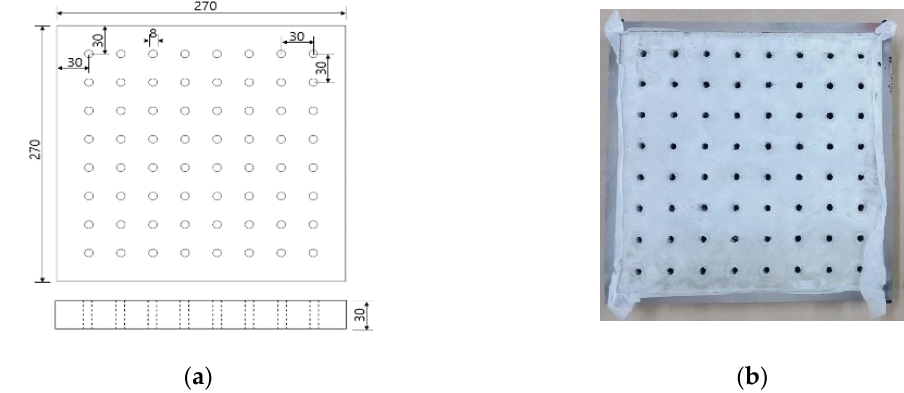
Figure 4. Proposed specimen structure, ( a ) base body dimensions, ( b ) completed specimen base. Table 4. Specimen assembly process.